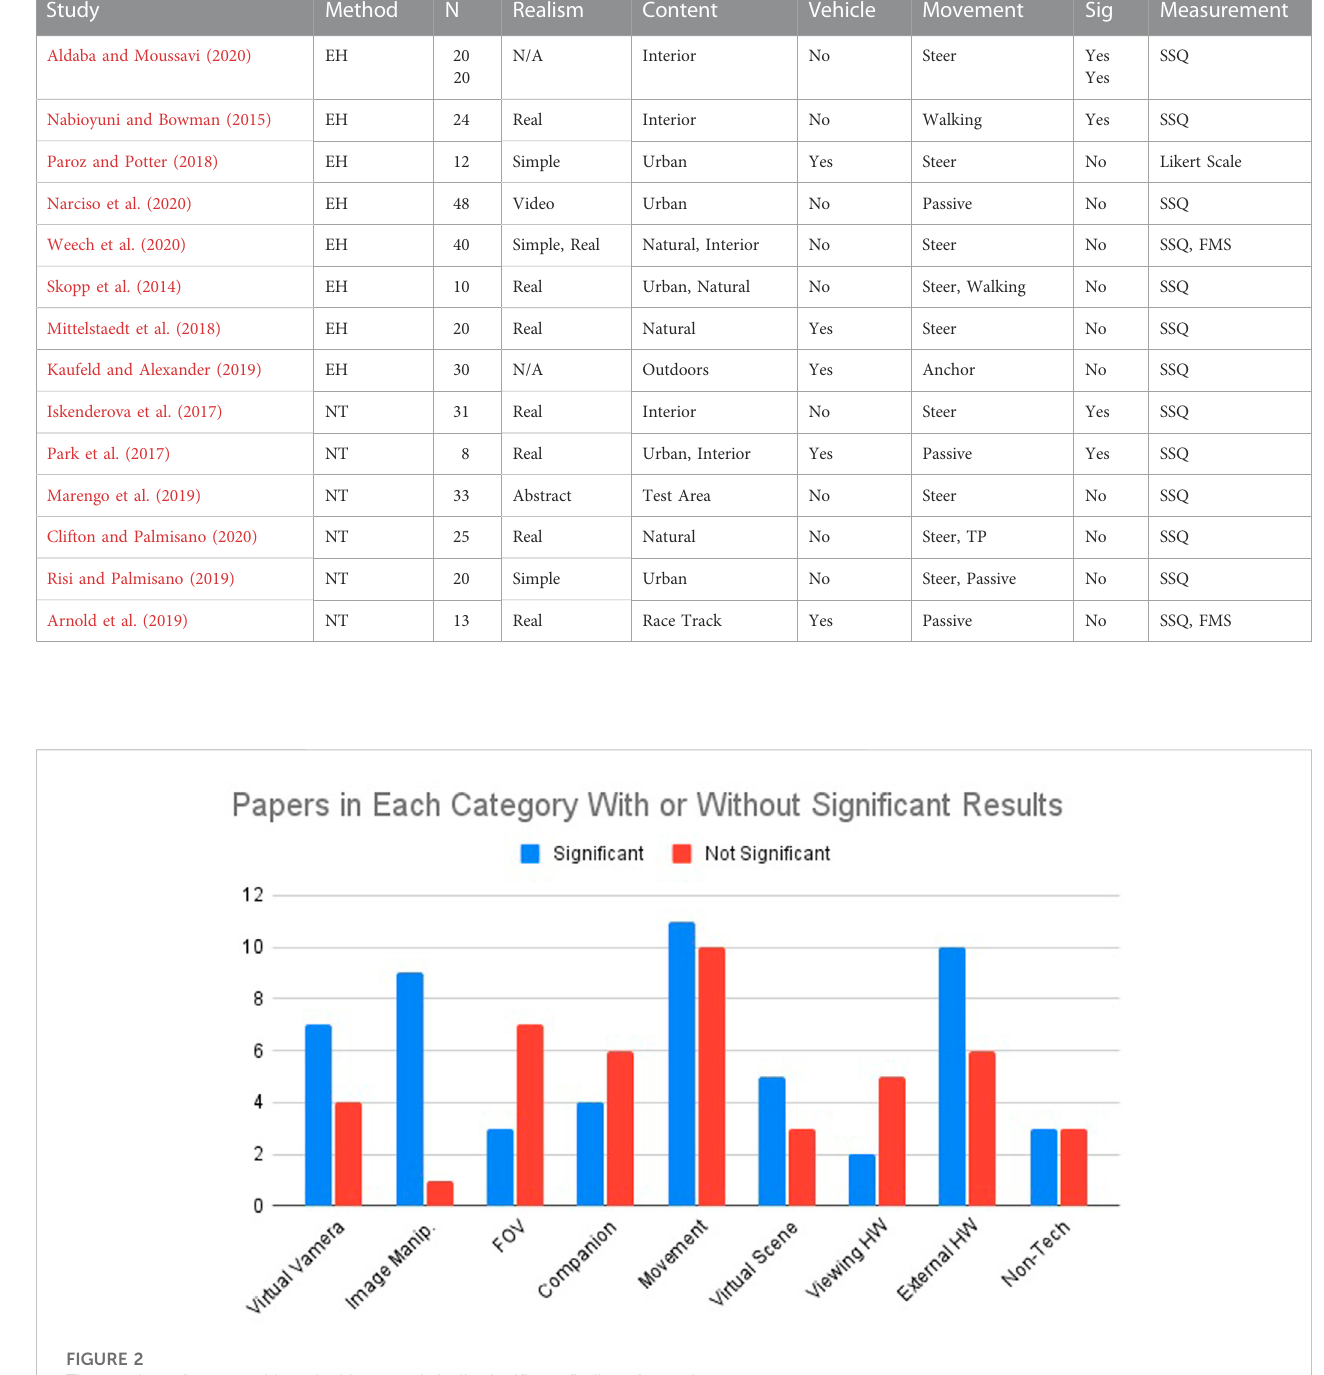
The number of papers with and without statistically signi fi cant fi ndings for each